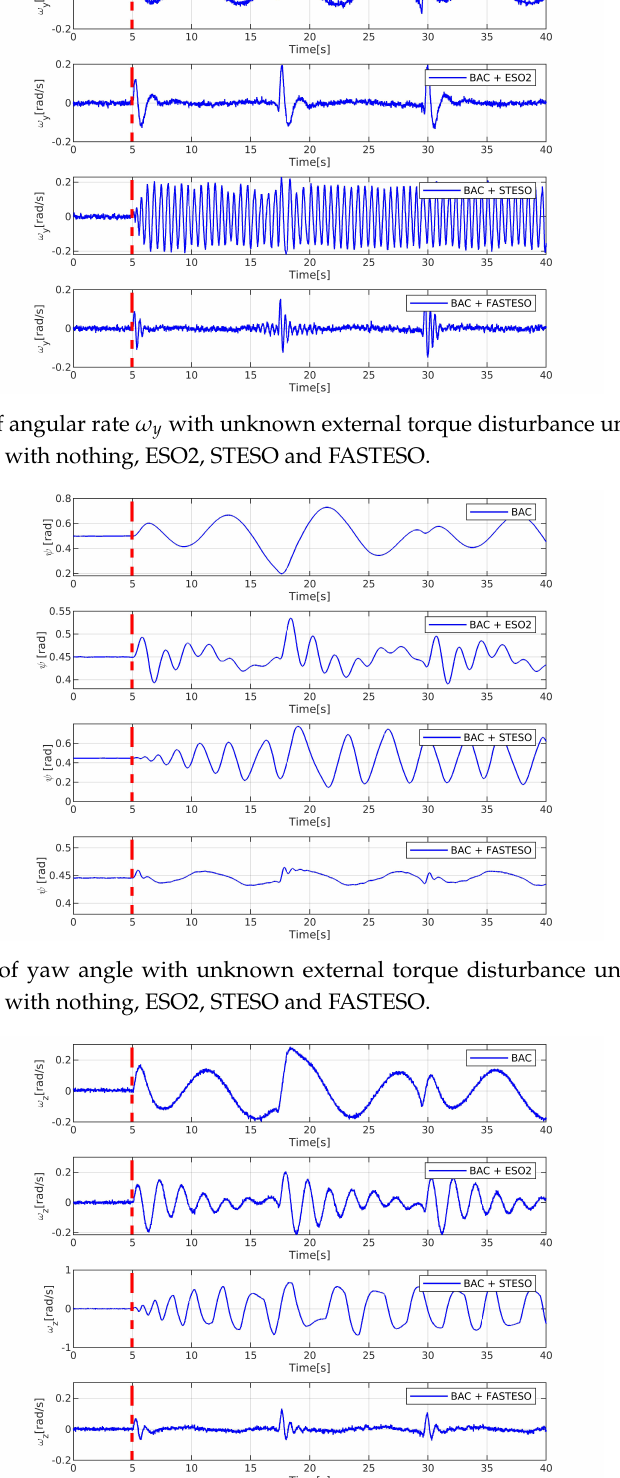
Figure 16. Results of angular rate ω z with unknown external torque disturbance under backstepping controller combined with nothing, ESO2, STESO and